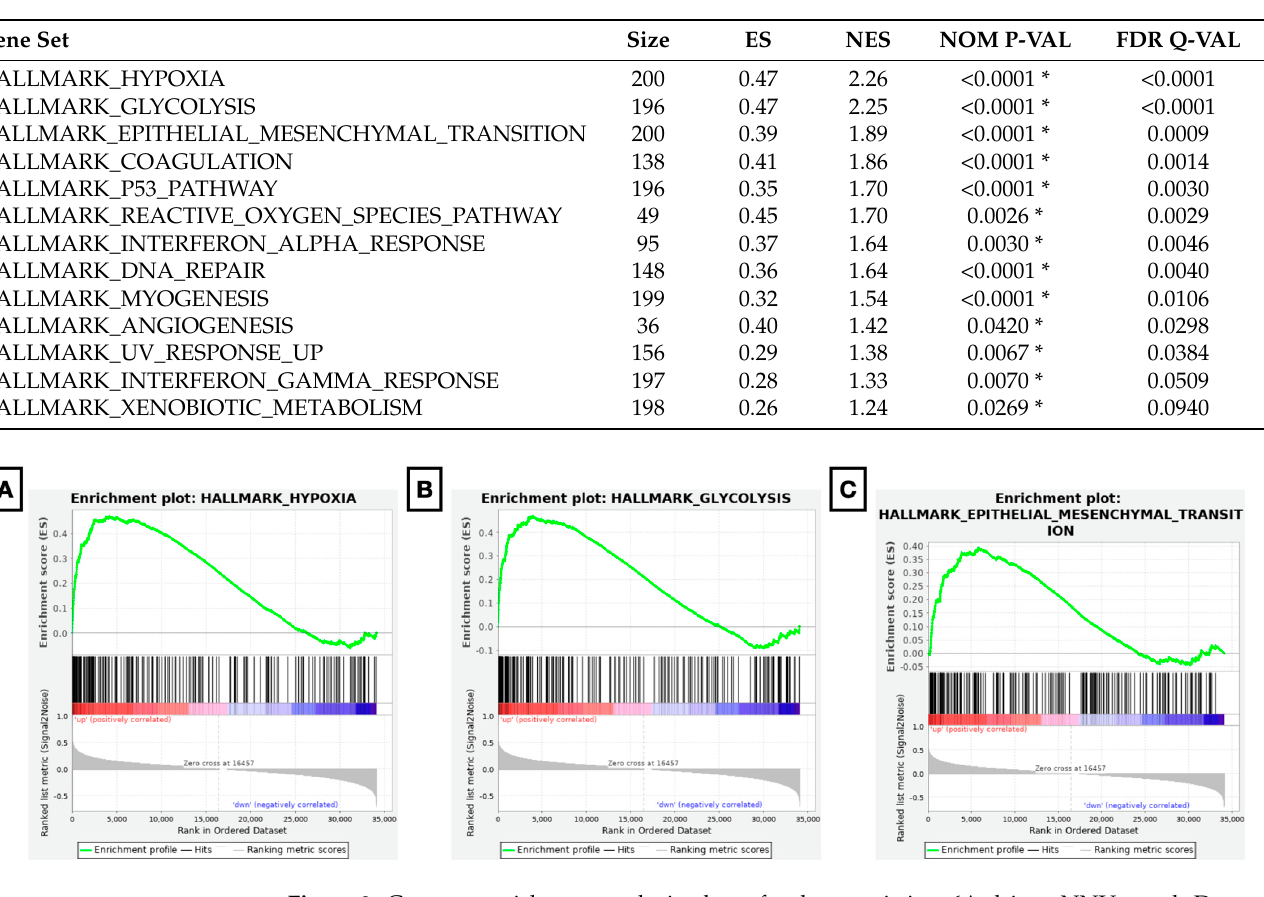
Figure 3. Gene set enrichment analysis plots of a characteristic m6A-driven NNU panel. Dysregu- lation of the NNU panel was found to be associated with critical biological processes, including ( A ) hypoxia (NES 2.26; p -value < 0.0001; FDR < 0.0001), ( B ) glycolysis (NES 2.25; p -value < 0.0001; FDR < 0.0001), and ( C ) epithelial-to-mesenchymal transition (NES 1.89; p -value < 0.0001; FDR < 0.001). Table 2. Characteristics of 13 significantly upregulated gene sets based on the NNU panel. Signifi- cance criteria comprise a p -value < 0.05 and a false discovery rate (FDR) < 0.25. ES = enrichment score, NES = normalised enrichment score, NOM P-VAL = normalised p -value, and FDR Q-VAL = false discovery rate q-value. * indicates significant p